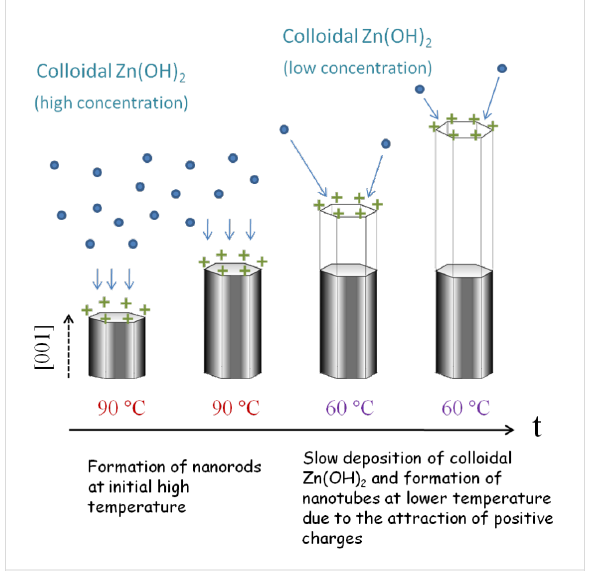
Figure 5: A schematic showing the evolution growth of ZnO nanocrys- tals from rod to tube shape as the growth temperature decreases.